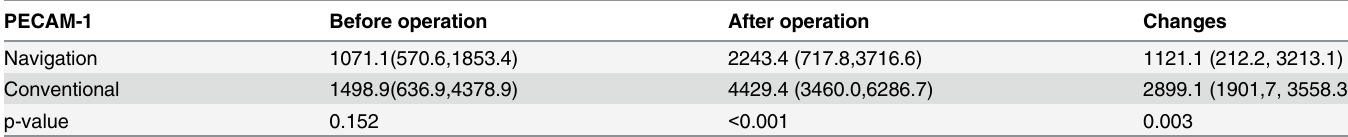
Table 4. Serum concentrations of PECAM-1 (unit: pg/mL) in patients before and after navigation and conventional TKAs, and the changes from preoperative baseline after surgery (post-OP — pre-OP). PECAM-1